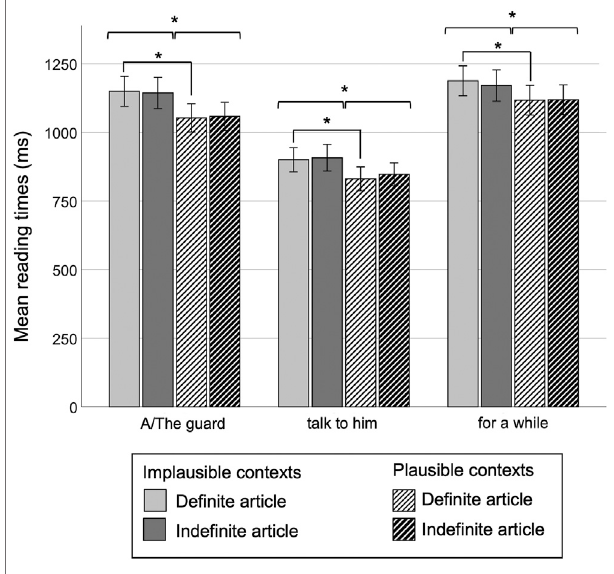
FIGURE 1 | Mean reading times in milliseconds for Experiment 1. Reading times in milliseconds (not log-transformed) for the critical segments, the fi rst and second spillover segments in the implausible-de fi nite, implausible-inde fi nite, plausible-de fi nite and plausible-inde fi nite conditions. Error bars represented 95% con fi dence interval. * p <